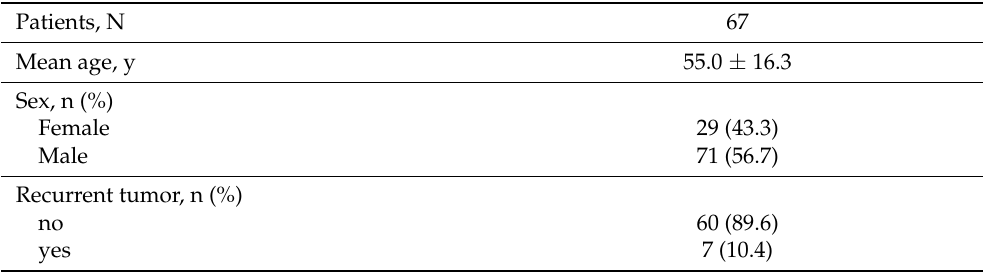
Table 1. Patient